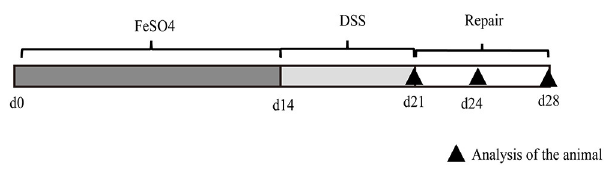
FIGURE 1 | Representative image of the experimental protocol used for the induction of ulcerative colitis in mice. Mice received normal iron content or high-iron diet from ferrous sulfate for 2 weeks (d1–d14) ( n = 36 for each group). From days 15 to 21, mice were treated with sodium dextran sulfate (DSS) (2.5% DSS in drinking water) and euthanized after DSS withdrawal (d21), or 3 days (d24) and 7 days (d28) after DSS withdrawal ( n =